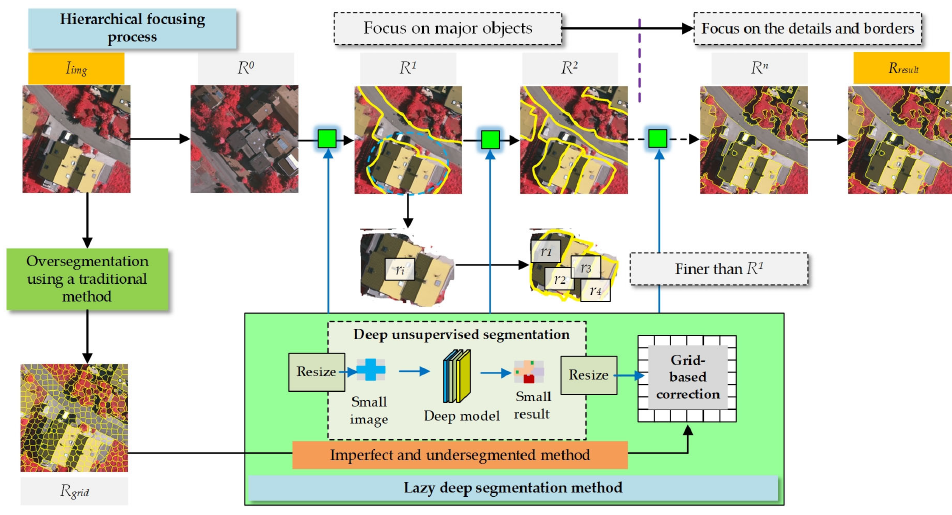
Figure 2. Overall design of HOFG .